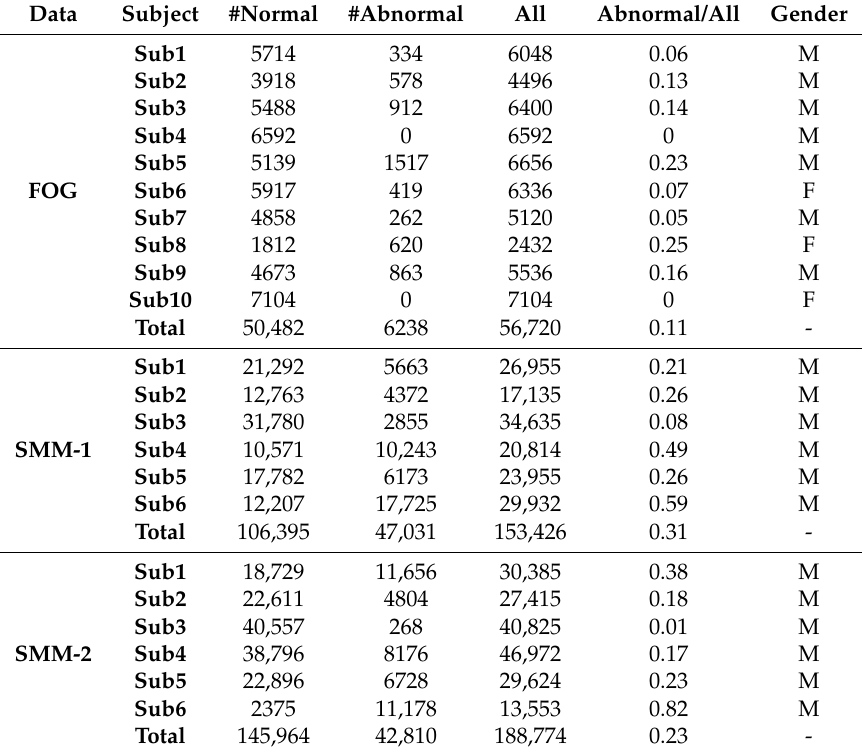
Table 1. The class distribution of normal and abnormal samples and the gender of patients in three